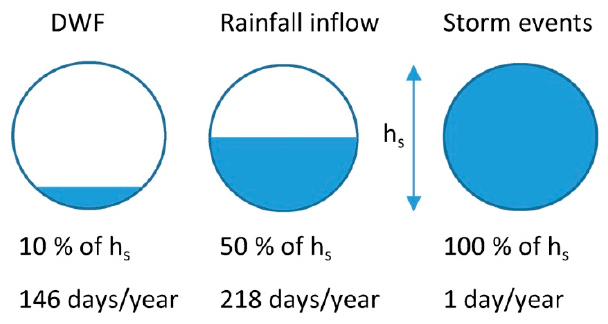
Figure 5. Scheme showing the different degrees (10%, 50%, 100%) of fullness in sewer pipes.